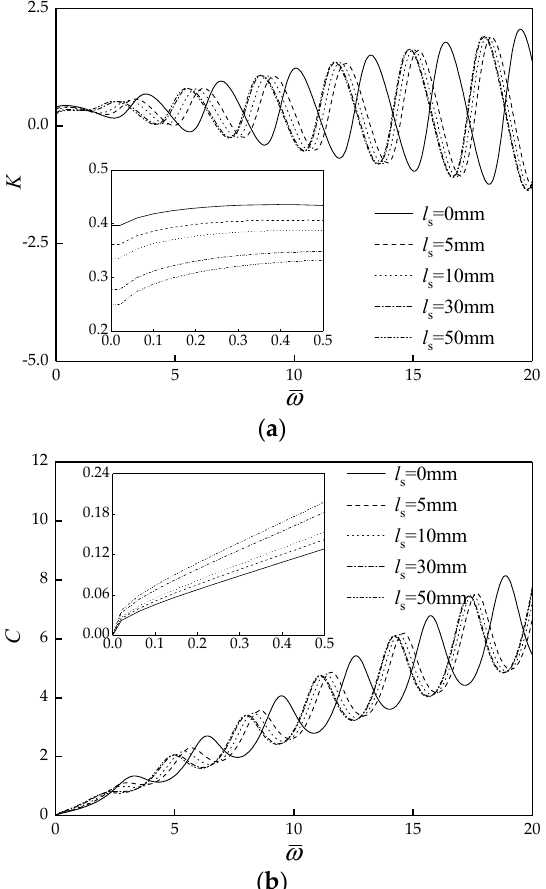
Figure 7. Effect of thickness of sediment on the vertical dynamic impedance of rock-socketed pile in case 1. ( a ) Dynamic stiffness curves; ( b ) Dynamic damping curves.